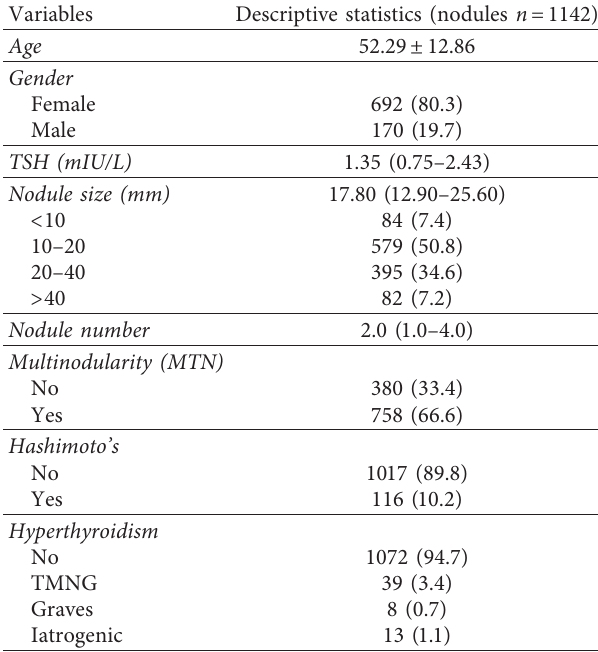
Table 1: Demographic and clinical